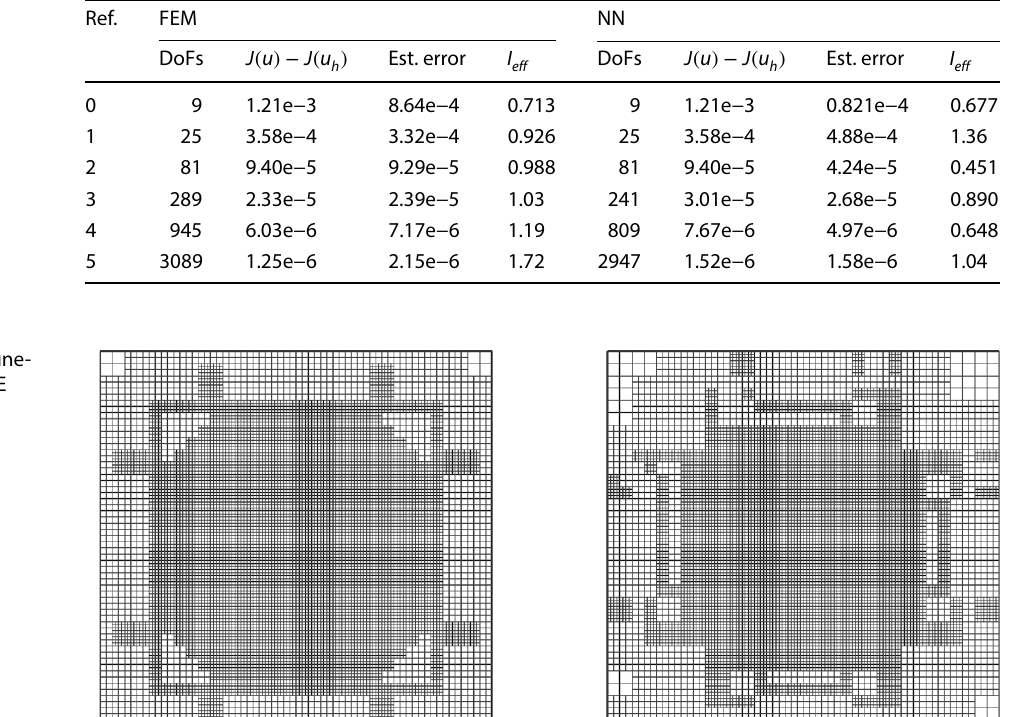
Table 6 Section 5.3: Error estimator results for the nonlinear PDE